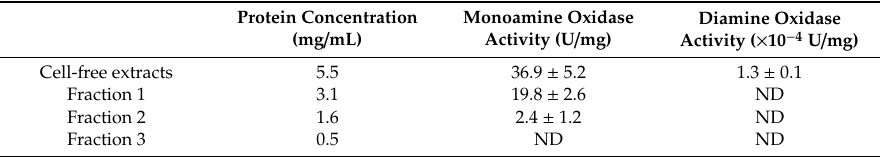
Table 4. The protein concentration, monoamine oxidase activity and diamine oxidase activity of the cell-free extracts (37 ◦ C, pH = 7).